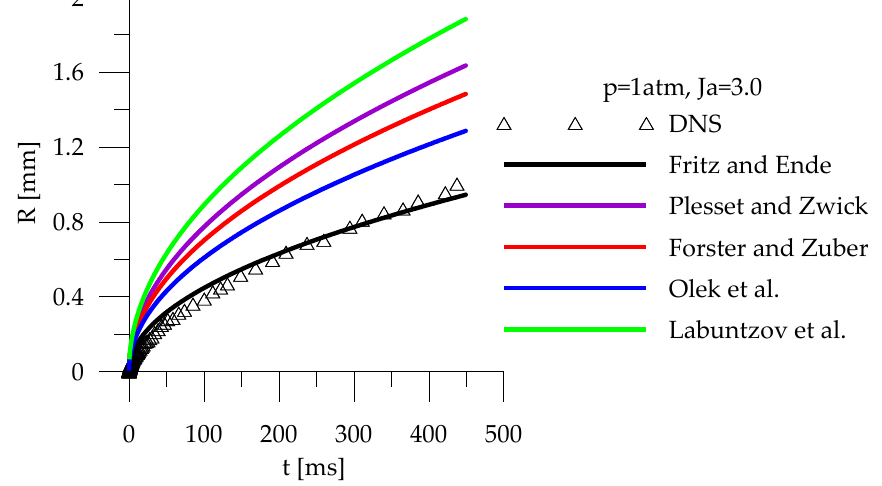
Figure 10. Two- fluid CFD and DNS simulated bubble growth at zero gravity (DNS data from [71], T sup = 1.0 K). CFD: Computational Fluid Dynamics, DNS: Direct Numerical